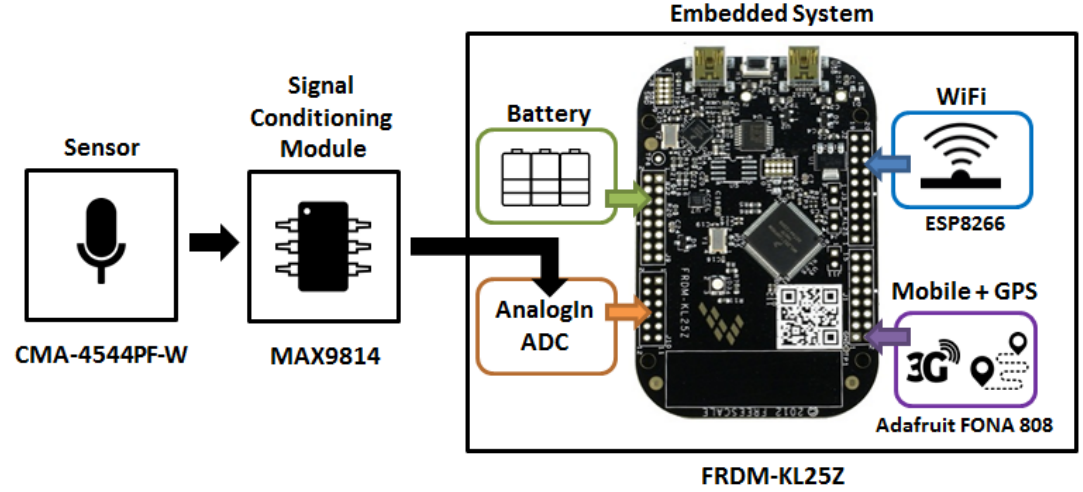
Figure 1. Suggested hardware platform. This is based on the FRDM-KL25Z embedded system. The microphone is the CMA-4544PF-W capsule followed by the MAX9814 amplifier. The platform also provides GPS, WiFi and mobile communications